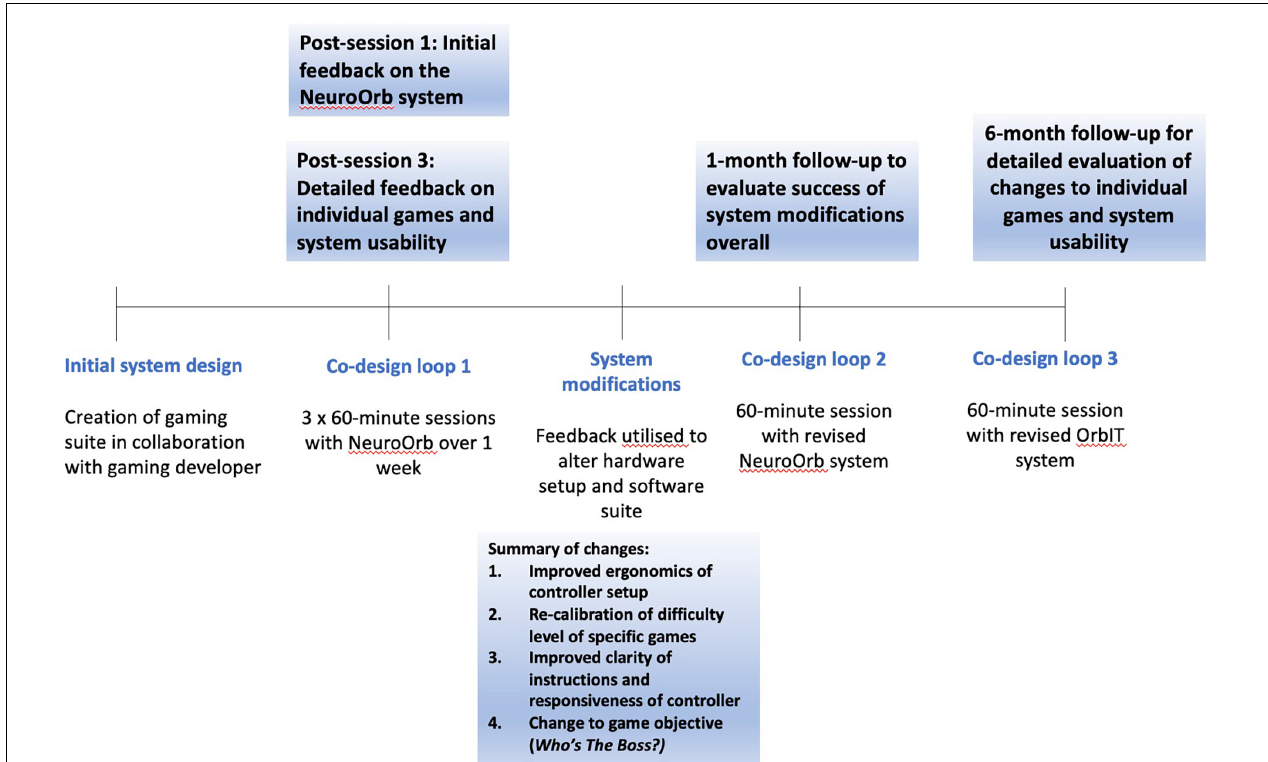
FIGURE 3 | A timeline of the co-design trial. The NeuroOrb system was first developed in collaboration with a gaming developer (BW). Participants were then invited to participate in three 60-min sessions over the course of a week, spaced 48 h apart. Extensive survey and verbal feedback was collected at the end of the first and third sessions. This feedback was then used to make significant changes to both the hardware and software of the NeuroOrb system. Following these changes ( ∼ 1-month post-exposure), participants were invited back for another 60-min gaming session and were encouraged to provide initial feedback on the changes made. They were then invited back a second time ( ∼ 6 months post-exposure) for a further 60-min session with the NeuroOrb system, followed by the completion of detailed feedback about the gaming suite and system as a